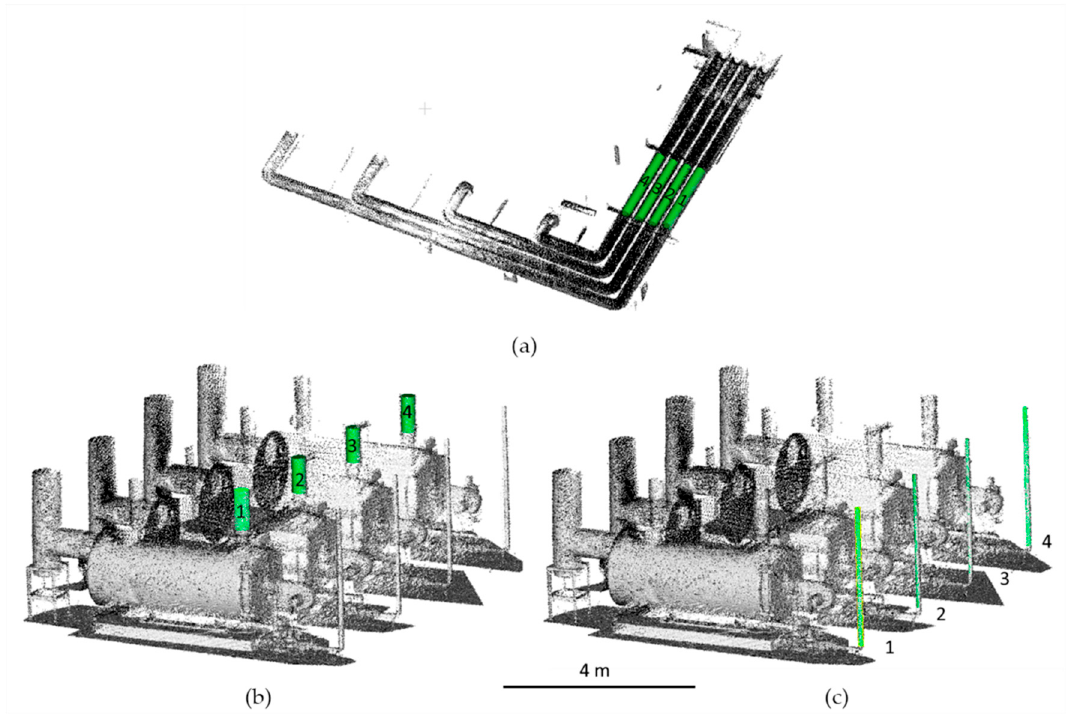
Figure 7. Regions of interest (pipes) used to fit the cylinder primitives: Water return pipe region located in the floor ( a ), water return pipe region located in the boiler ( b ), and gas pipe region ( c ).